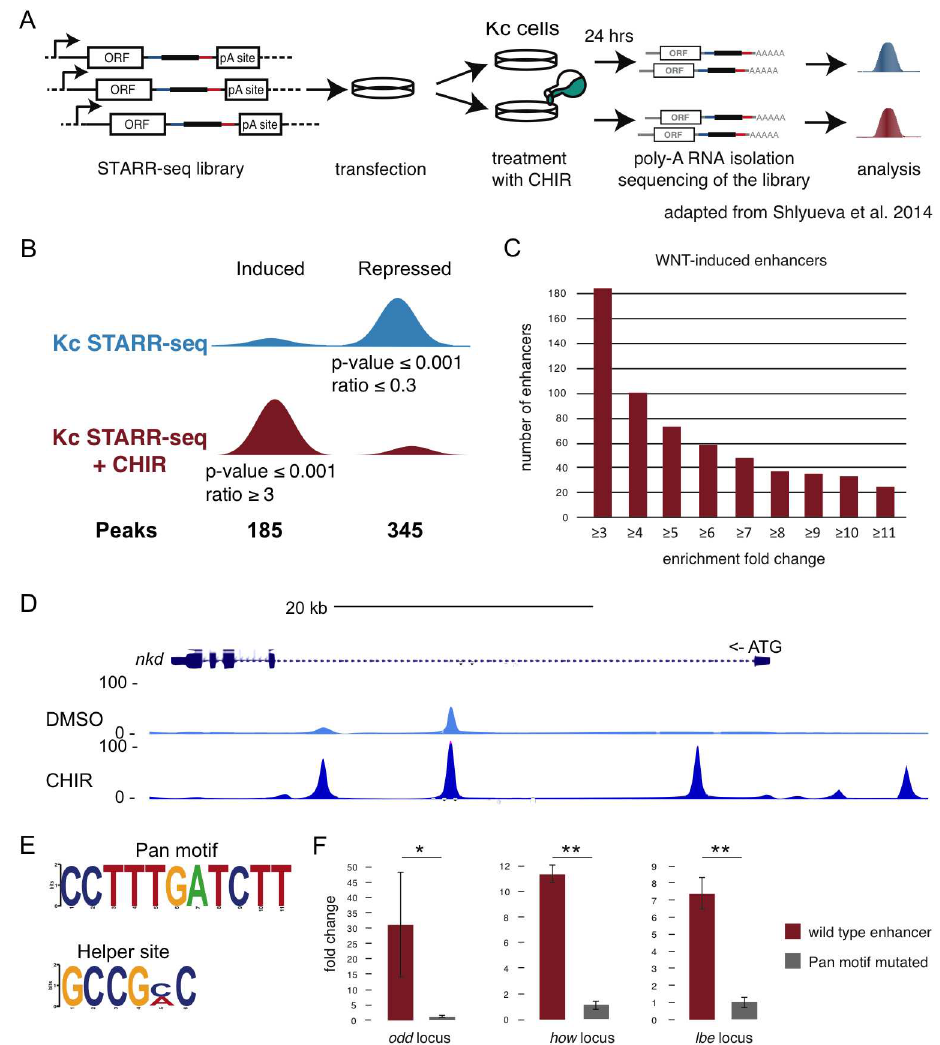
Fig 6. Identification of Wnt/Wg-responsive enhancers. (A) Schematic overviewof the STARR-seq experimental setup (adaptedfrom [45]). (B) CartoonrepresentingSTARR-seq peaks that were inducedor repressed after activationof the Wnt/Wg pathwayand the number of such peaks. (C) Distribution of induced peaks accordingto their fold induction. (D) UCSC genome browserscreenshotof STARR-seq tracks in the nkd gene loci. (E) PWM logos for the Pan and Helpermotif. (F) Fold inductionof normalized luciferasesignal for inducedenhancersnear odd , how and lbe genes. In red: wild-typesequences;in grey: sequenceswith mutated Pan motif. All DNA sequencesare listed in S3 Table. Paired t-test: * p-value = 0.01; ** p-value (cid:20) 10–4. Data are shown as mean ± SD of two experiments.